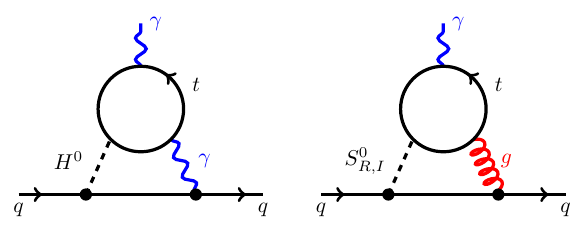
Figure 1 . Opposed to the THDM with colourless scalars (left), the leading contribution to the light quark EDM appears in the MW model through gluon exchange (right), enhancing the EDM by a factor ( C F α s ) /α ∼ 50 , with the couplings evaluated at the hadronic scale.